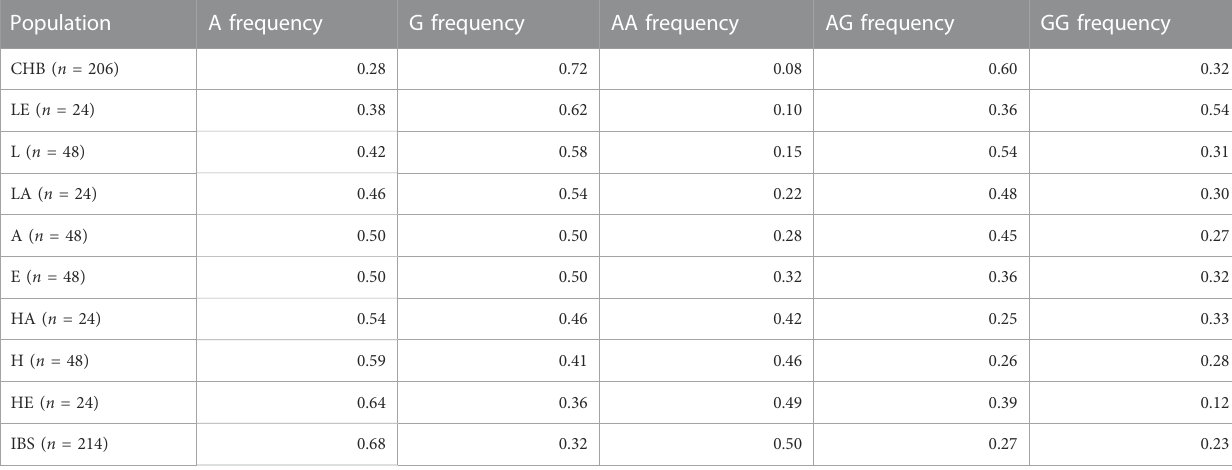
TABLE 1 Allele frequency and genotype proportions for site rs10166384 among the Bolivian samples as well as East Asian and European populations from the 1,000 genomes project.